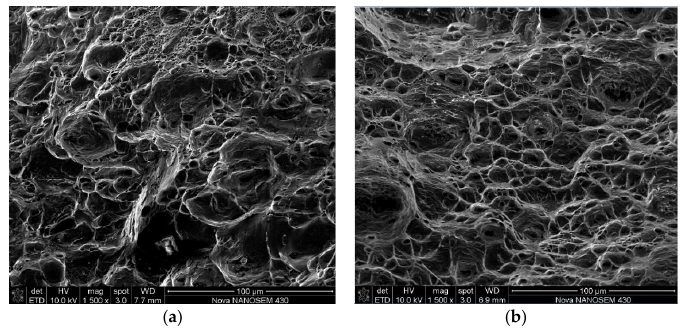
Figure 8. Photographs of fractured tensile samples: ( a ) Sample 1, ( b ) Sample 2.